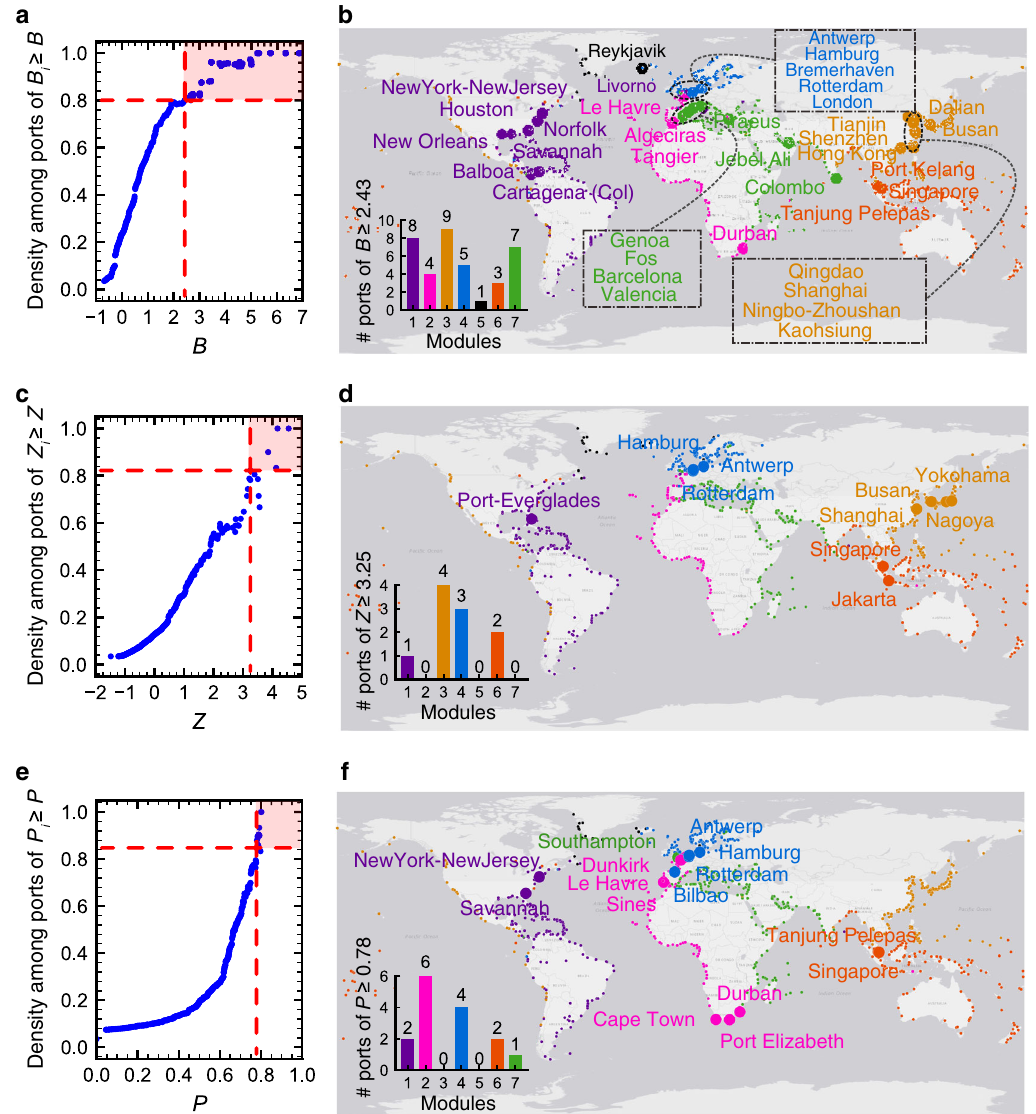
Fig. 6 Structural core detection of the GLSN. A structural core of the GLSN is de fi ned as a set of hub ports that meet two criteria: fi rst, this set should consist of the largest number of the most important hub ports that form a subgraph of high density (i.e., here at least 0.8); second, this set should contain at least one hub port from each module in the network. In implementation, we fi rst calculated the connection densities among ports with largest values of B , Z , and P , as presented in plots a , c , and e , respectively. Red regions in the parameter spaces of these three plots correspond to the three respective sets of hub ports that meet the fi rst criterion: ports of B ≥ 2.43, forming a subgraph of density 0.80; ports of Z ≥ 3.25, forming a subgraph of density 0.82; and ports of P ≥ 0.78, forming a subgraph of density 0.85. These three sets of hub ports are further displayed by big dots in geographical plots b , d and f , as well as their respective distributions over different modules (insets). Then, we could evaluate whether any of the three sets meet the second criterion. It turned out that only the set of ports of B ≥ 2.43 met this criterion and thus constituted a structural core of the GLSN, while the other two sets did not. Modules are indicated by color. Pseudocode of the algorithm for structural core detection is available in Supplementary Note As ports of the GLSN were divided into structural-core and non- SD = 6059 km), 1.5 times; local connections (average = 3585 km, structural-core ports, edges were naturally categorized into three SD = 4379 km), 0.7 times. When looking at the shipping distance for topological types (Fig. 8a): core connections linking structural-core cargo transportation among all the non-core ports in the GLSN ports, feeder connections linking structural-core ports and non- (Fig. 8c), we found 16.7% of the total shipping distance — measured structural-core ports, and local connections linking non-structural- by the distance along the edges of their shortest paths — is taken up core ports. Statistical analysis revealed the importance of core by core connections. As core connections only account for 3.2% of connections in supporting long-distance maritime transportation. the total number of inter-port connections in the GLSN, it makes a First, core connections tend to be longer than feeder and local ratio of distance fraction to the connection fraction to be 5.2, relative connections (Fig. 8b). Measured by real nautical distance, the average to 1.7 and 0.4 for feeder connections and local connections, length of core connections (average = 10233 km, SD = 6567 km) is respectively. When considering those shortest paths that pass 2.0 times of the average over all inter-port connections (average = through the structural core (i.e., traveling across at least one core 5116 km, SD = 5482 km); feeder connections (average = 7612 km, connection), the proportion of shipping distance taken up by core